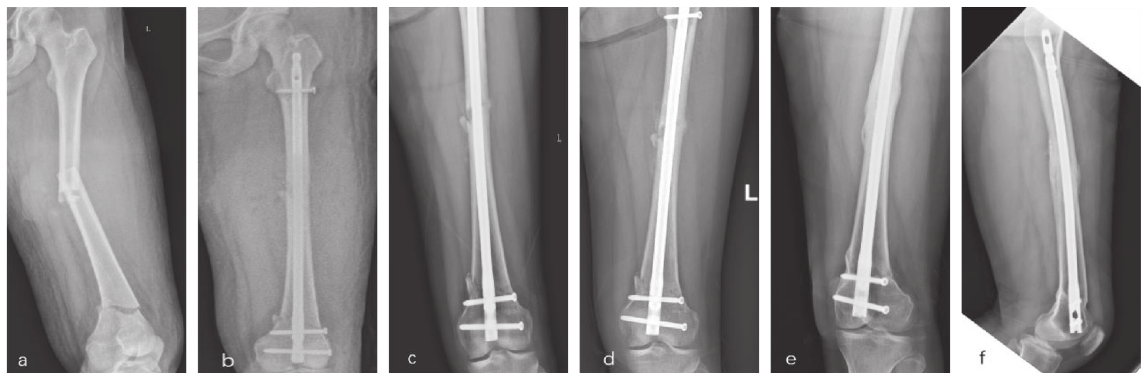
Figure 3: Female, 33, multi-fragment fracture of left femur with AO classification A3 in shaft, and A1 in distal part (a). Treated with retrograde nailing and postoperative FIB, 1-day postoperative radiograph (b). 1month (c), 3-month (d) follow-up radiographs. 9-month follow-up radiographs indicated union (e, f).